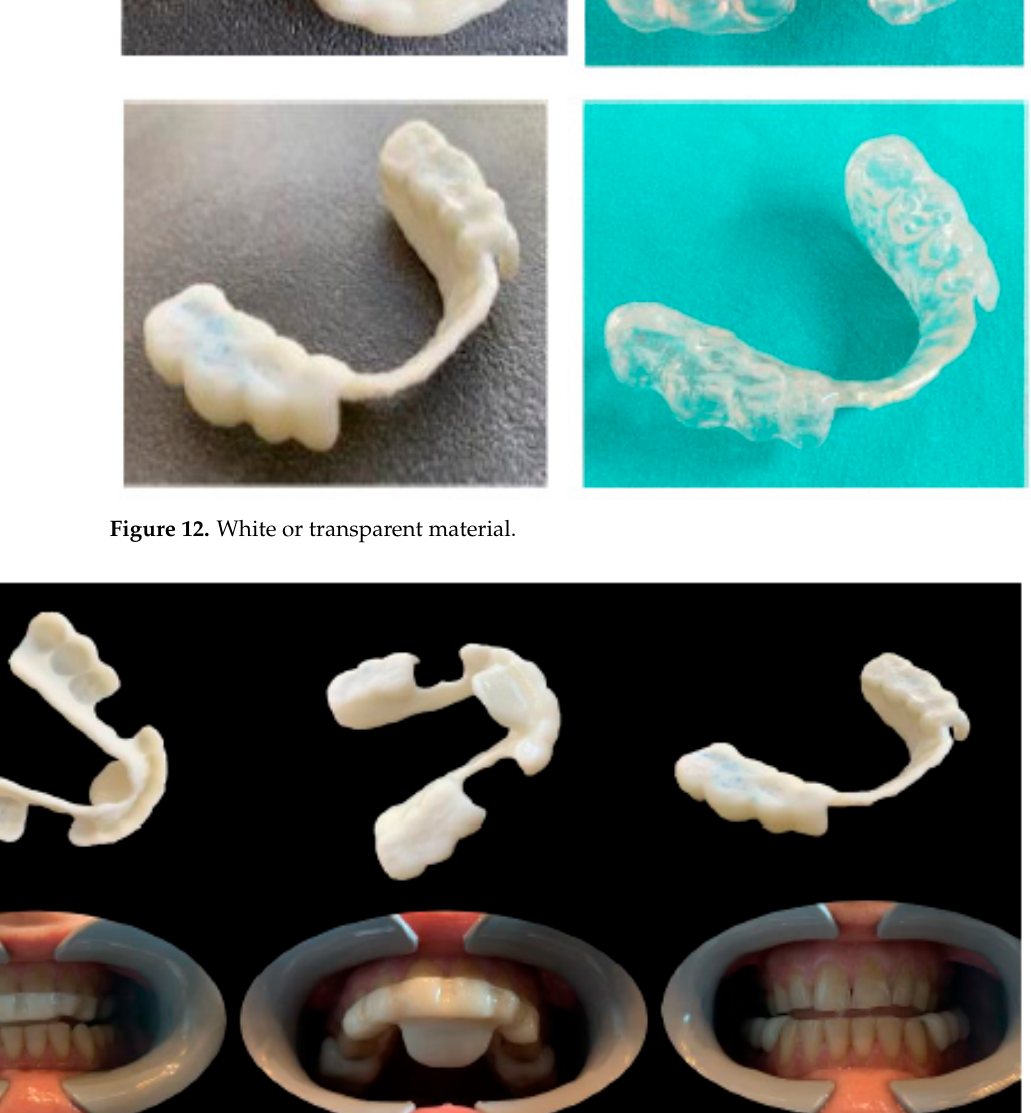
Figure 13. Digitally printed devices, without metal parts, made for the lower and upper arches on the basis of the therapeutic position identified during the diagnostic checkup. Ideally, the devices can be designed and printed on the same day of the visit (one-day full-digital workflow).